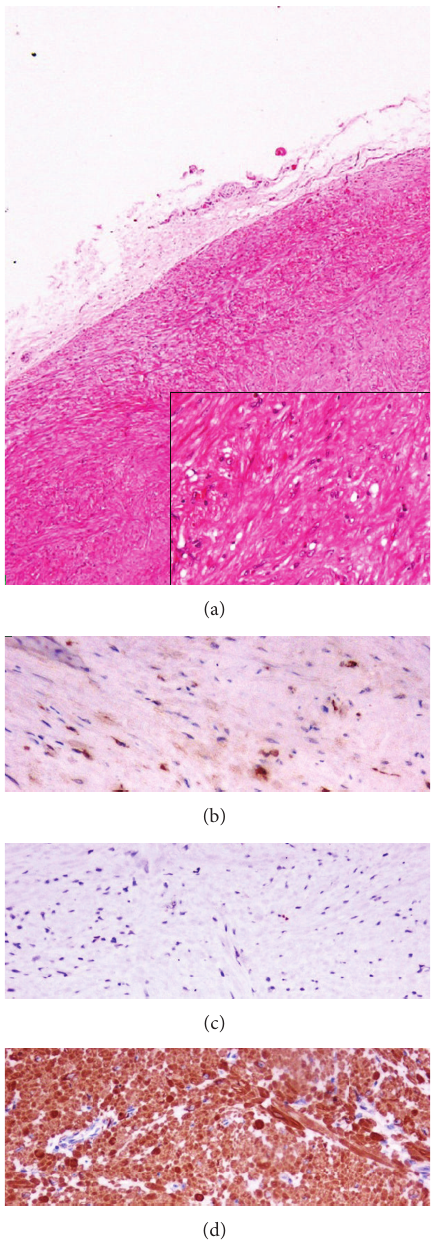
Figure 2: Microscopic view of the tumor. (a) H/E × 40 (inset H/E X200), (b) c-kit × 200, (c) Ki-67 × 200, and (d) SMA (a smooth muscle actin) ×